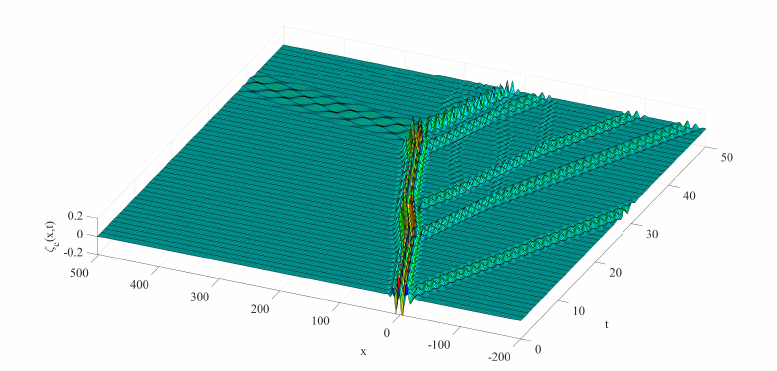
Figure 19. Variation of the free surface displacement ζ c ( x , t ) (m) versus x (m) and time t (s) in the case of a semi-infinite plate in the presence of single breakwater.